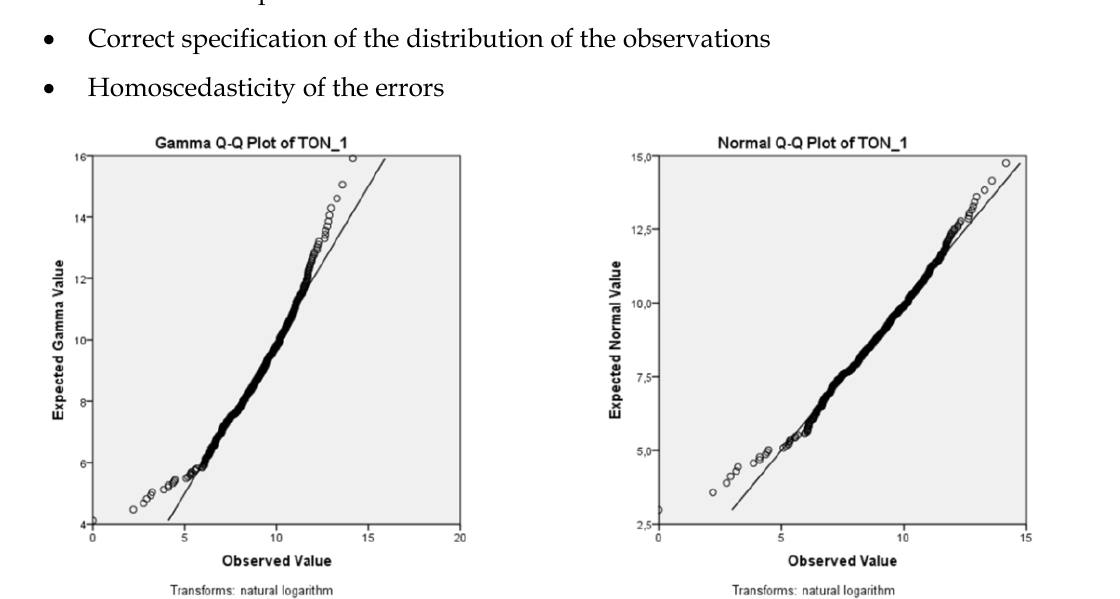
Figure 4. Q-Q plots for commodity type ‘foodstuff and animal folder’ according the GLGLM regression technique (left) and the GLML regression technique